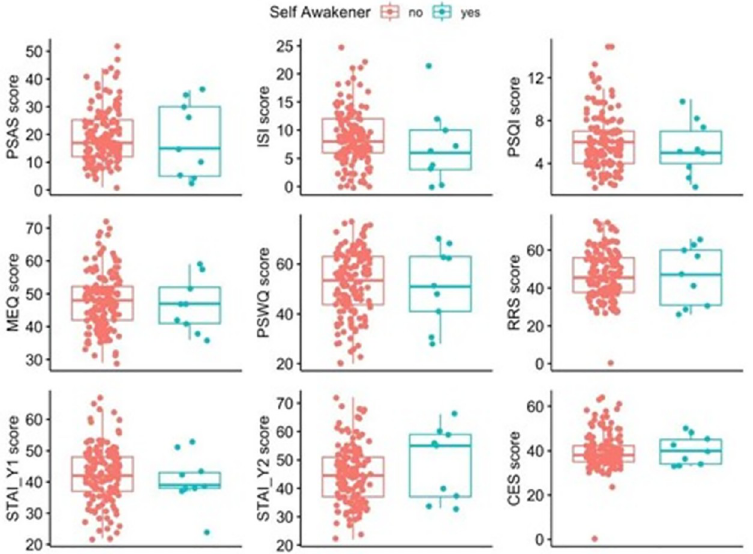
Fig 3. Differences between Self-Awakeners (n = 9) and non-Self-Awakeners (n = 144) by test scores. The difference between groups was non-significant for all measures. For all boxplots, each box contains the interquartile range (i.e., the range containing 50% of all observations) and the median value (middle line), while the whiskers represent values extending outside 50% of the observations. Abbreviations: ISI = Insomnia Severity Index; MEQ = Morningness- Eveningness Questionnaire; PSQI = Pittsburgh Sleep Quality Index; PSWQ = Penn State Worry Questionnaire STAI = State-Trait Anxiety Inventory; BDI = Beck Depression Inventory RRS = Ruminative Response Scale; PSAS = Pre-Sleep Arousal Scale; CES = Center for Epidemiologic Studies Depression Scale (see S1 File for details).